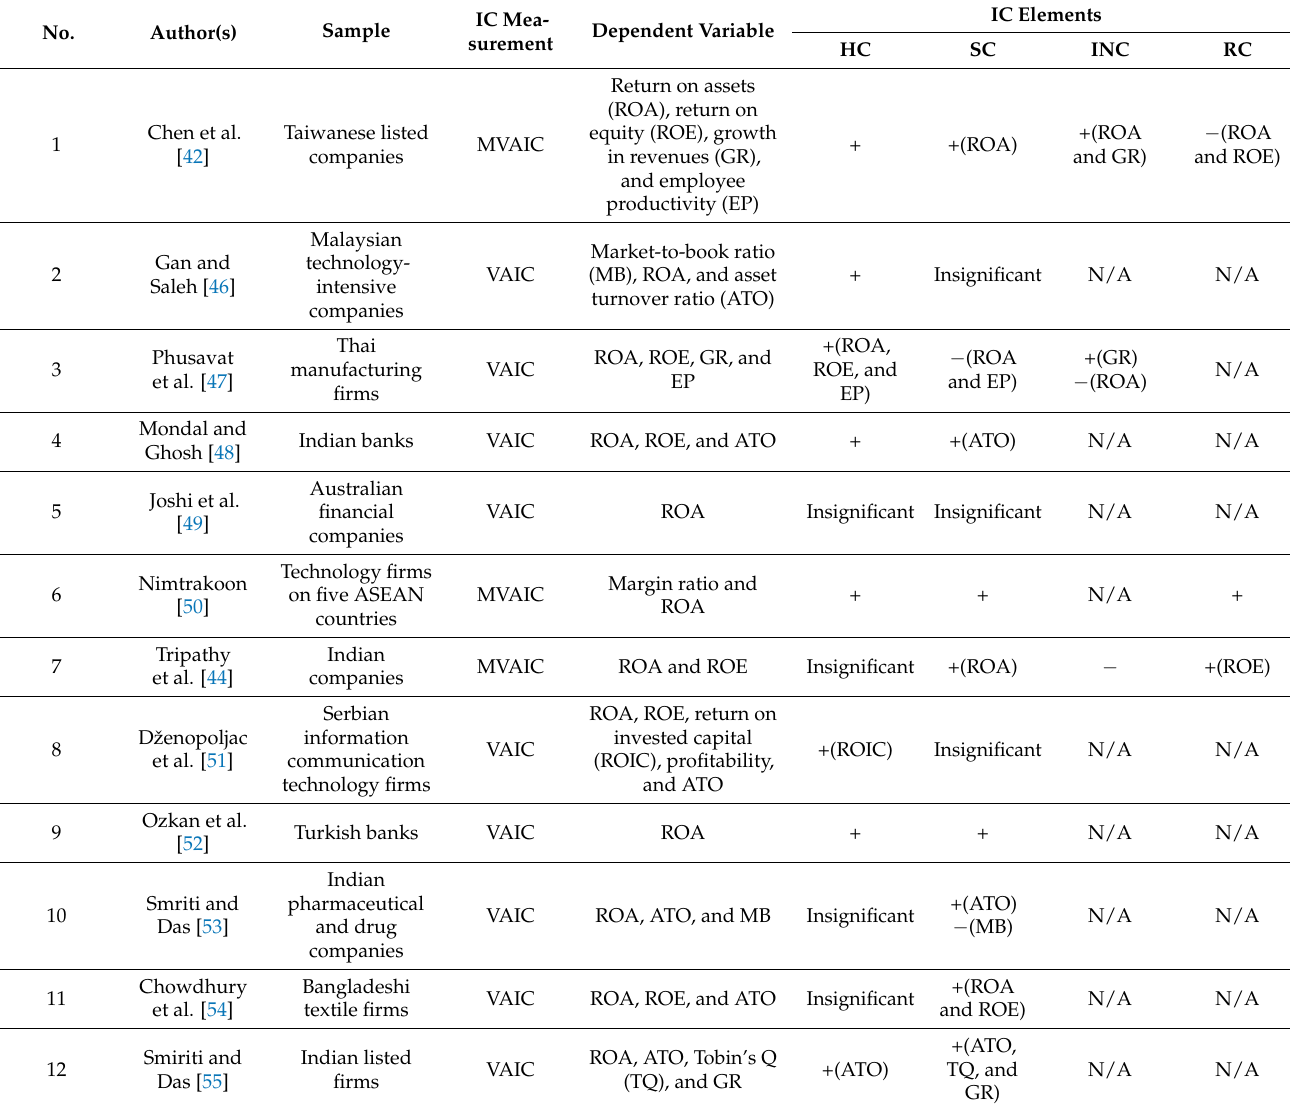
Table 1. Overview on IC and financial